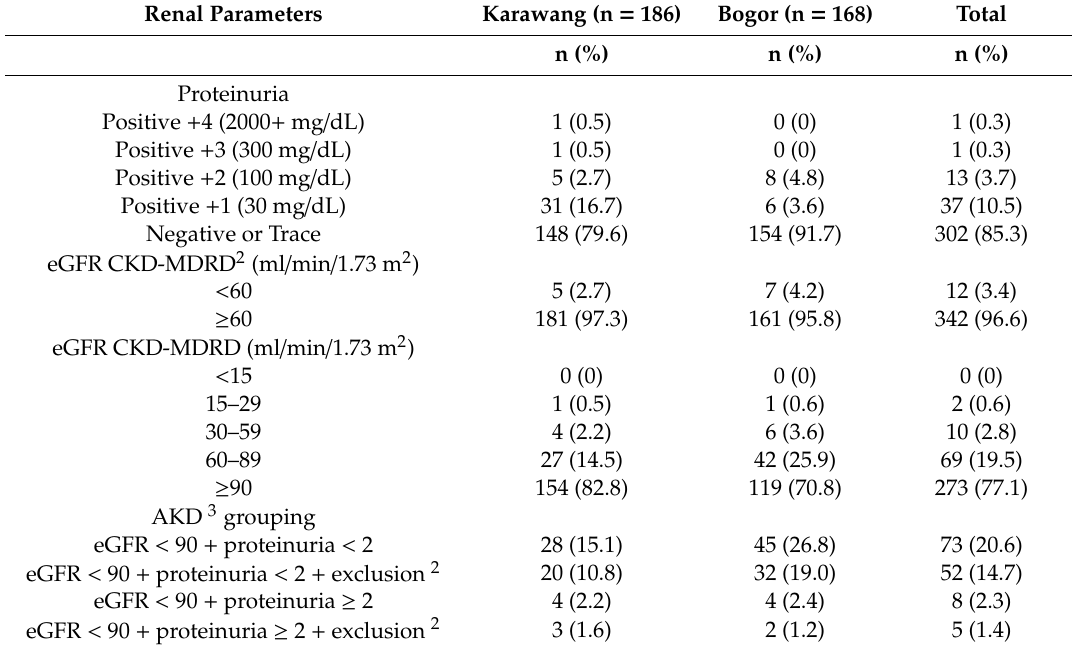
Table 1. Distribution of renal parameters of male farmers in Karawang Regency and Bogor Regency, West Java 1